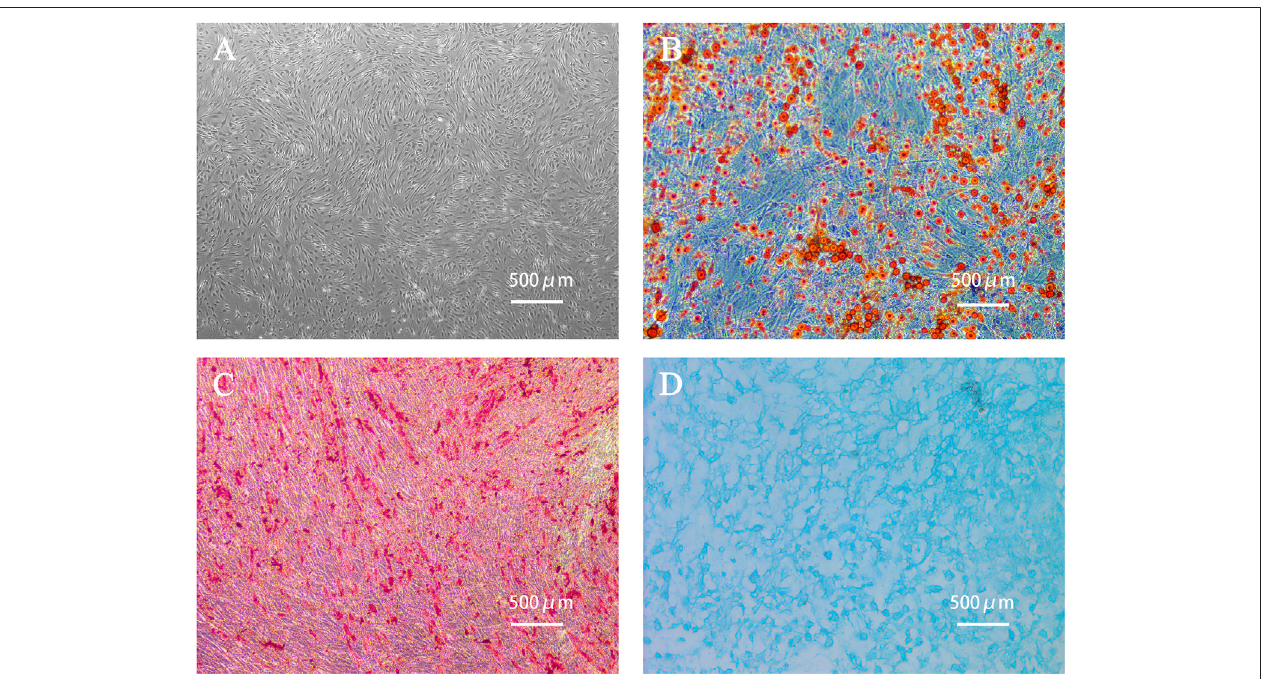
FIGURE 2 | Human adipose-derived stem cells (ADSCs) and cell morphology after differentiation. (A) The fourth generation of ADSCs grew in colony vortex. (B) Human ADSCs were stained with Oil red O after adipogenic differentiation. The red parts are lipid droplets. (C) Alizarin red staining after osteogenesis induction and differentiation of human ADSCs. The red parts are calcium nodules. (D) Alcian blue staining after induction and differentiation of human ADSC chondroblast. The blue part is the endoacidic mucosaccharide in cartilage